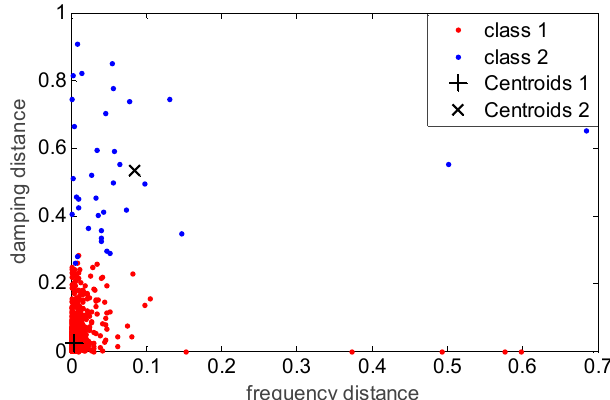
Figure 5. The distribution of the two clusters of the dataset measured at 13:00 of 12 April in the two-dimensional projections of frequency distance vs. damping distance.